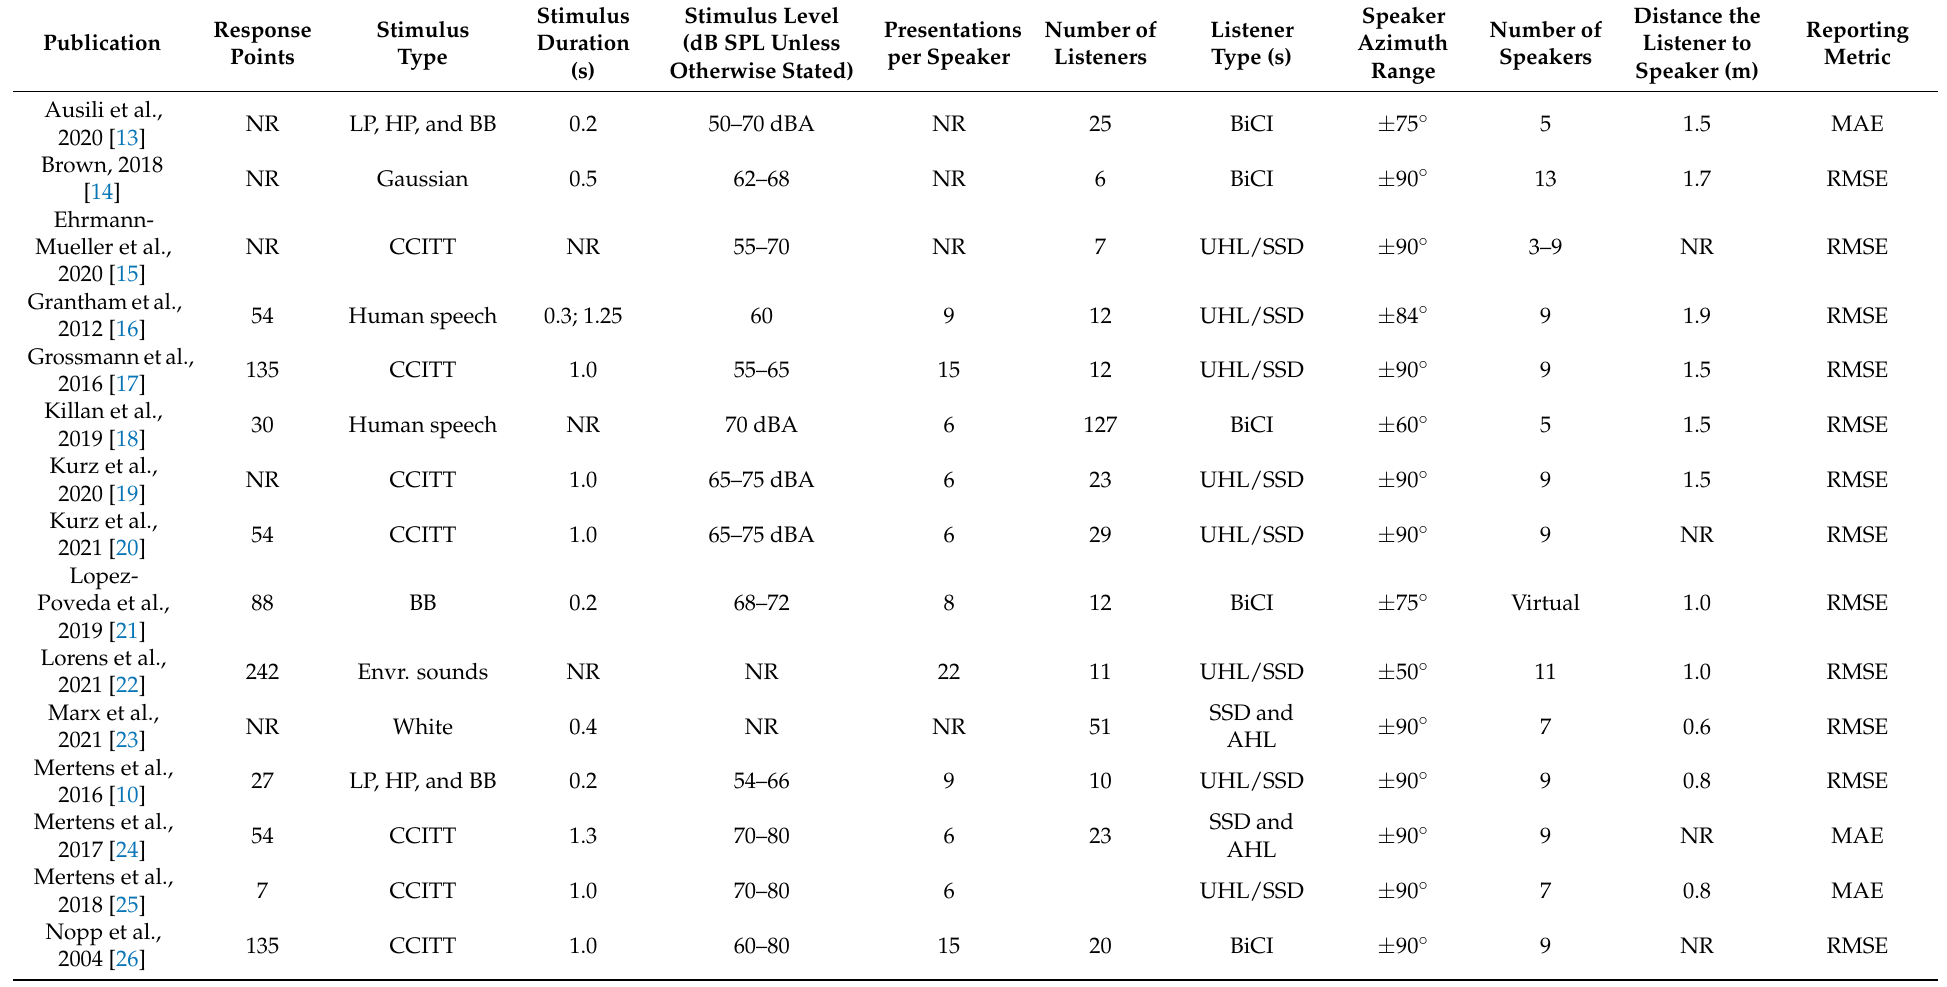
Table 1. Examples of variations in localization testing procedures and reporting metrics from recent studies. NR: not reported, LP: low-pass, HP; high-pass, BB, broadband